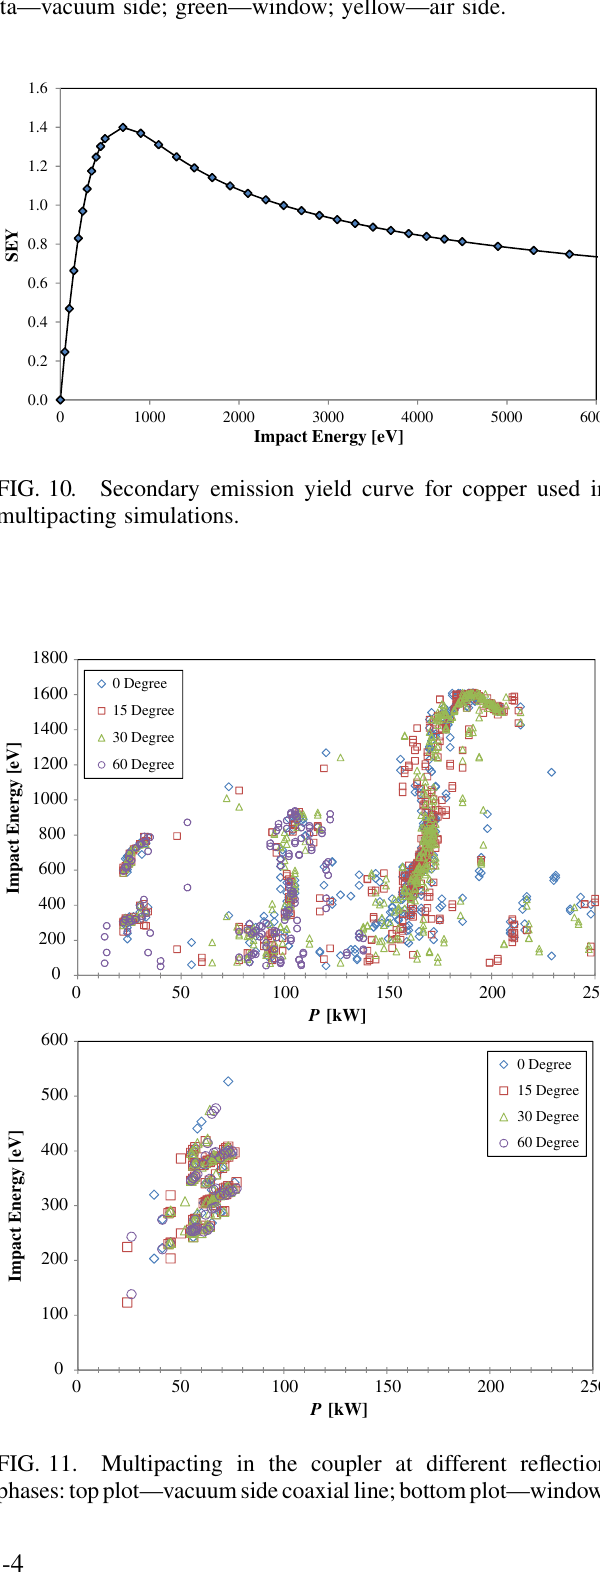
FIG. 9. FPC model for multipacting simulations: magenta—vacuum side; green—window; yellow—air side.